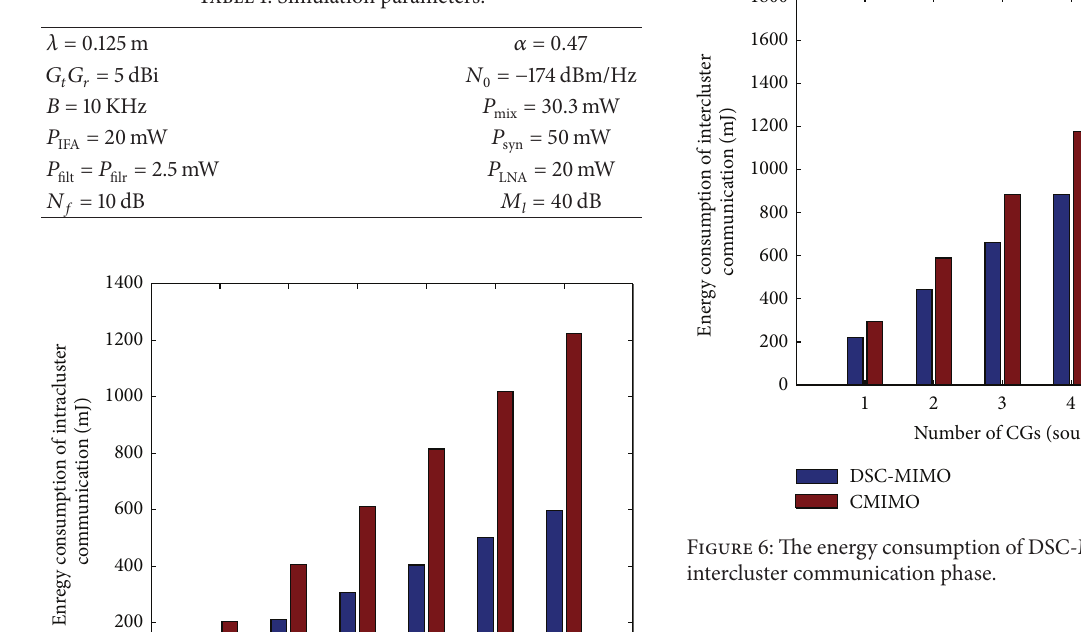
Table 1: Simulation parameters.